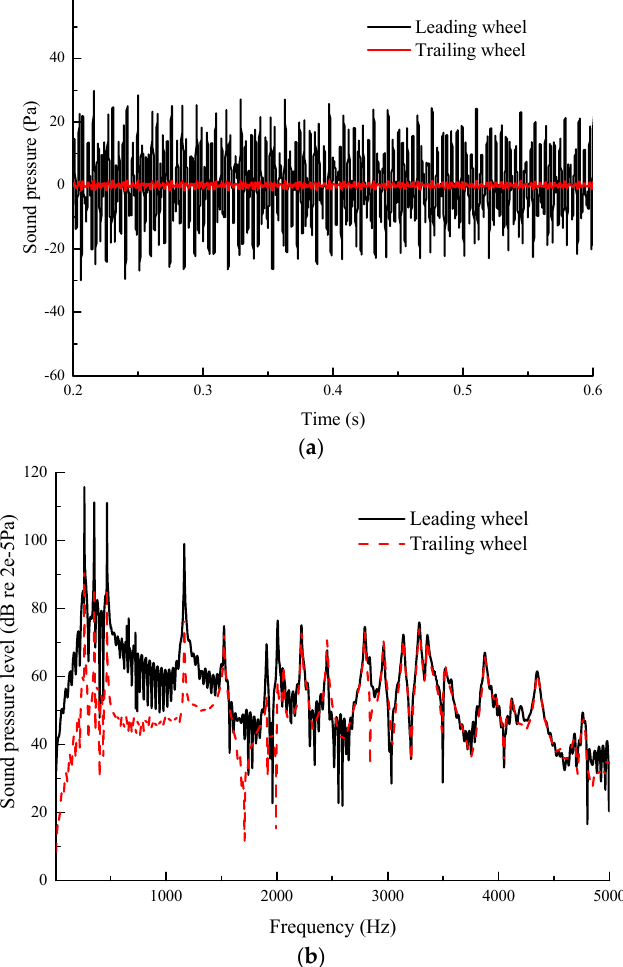
Figure 10. SPLs at a distance of 30 cm from the leading and trailing wheels in ( a ) time domain and ( b ) frequency domain (simulation results).